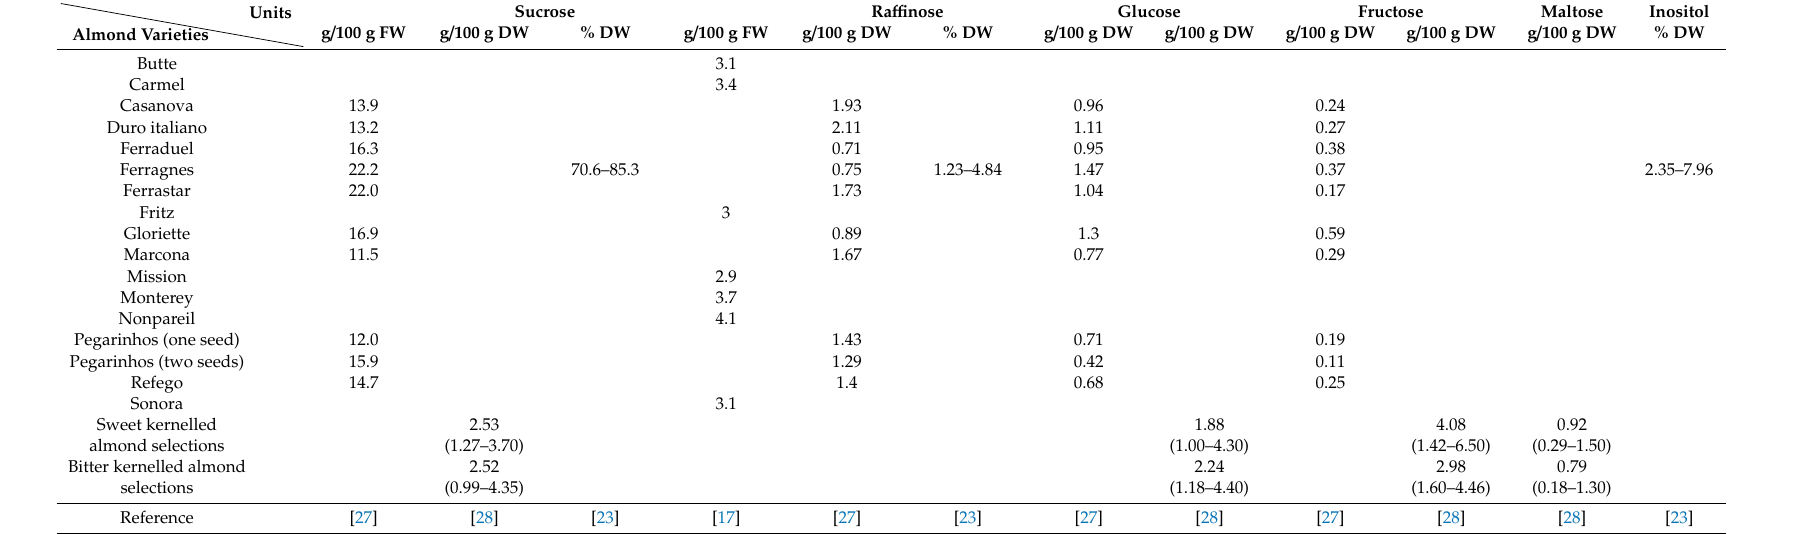
Table 4. Sugar content of di ff erent varieties of almonds ( Prunus dulcis Mill. D. A.